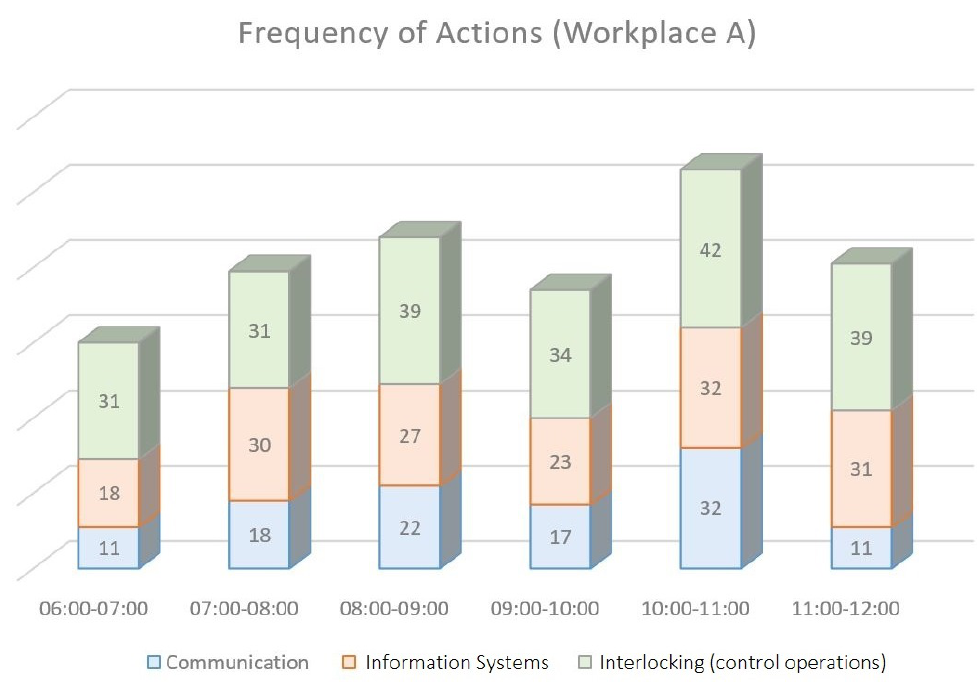
Figure 3. Frequency of actions distributed over time intervals at workplace A (period